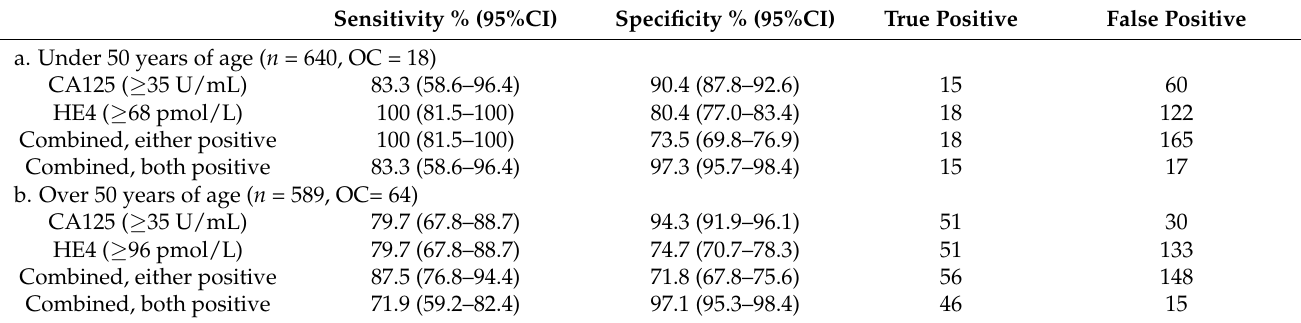
CI—confidence interval. PPV—positive predictive